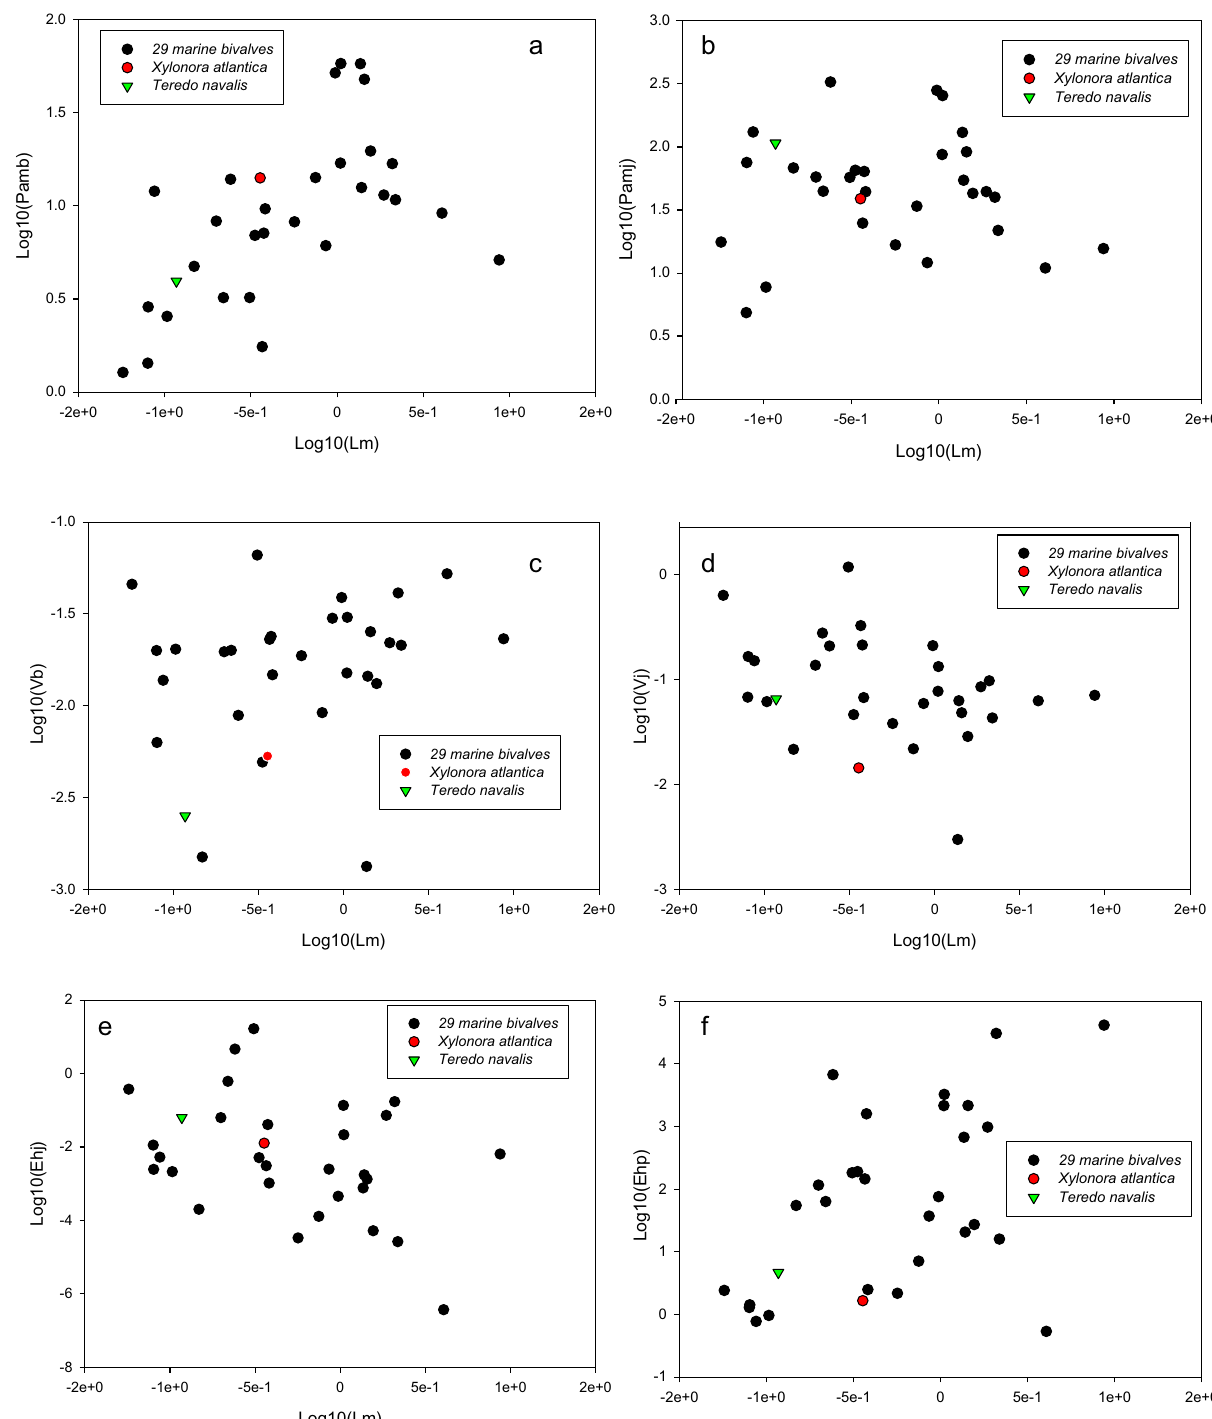
Figure 2. Interspecific comparison of abj-DEB parameter values of 29 marine bivalves with those of the deep-sea wood borer Xylonora atlantica and the shallow wood borer Teredo navalis , scaled to body size (Lm: maximum structural length) ( a ) Pamb , maximum assimilation rate at birth (cid:31) ˙ p Am (cid:30) ), ( b ) Pamj, maximum b assimilation rate after metamorphosis (cid:31) ˙ p Am (cid:30) ; ( c ) Vb , energy conductance at birth ˙ v b ; ( d ) Vj , energy j j conductance after metamorphosis ˙ v j ; ( e ) Ehj , energy threshold after metamorphosis E H , and ( f ) Ehp , energy p threshold at puberty E H . The black circles are the values for the 29 marine bivalves for which an abj-DEB model was applied. The red circles are the DEB parameter values of X. atlantica. The green triangles are the DEB parameter values of T. navalis